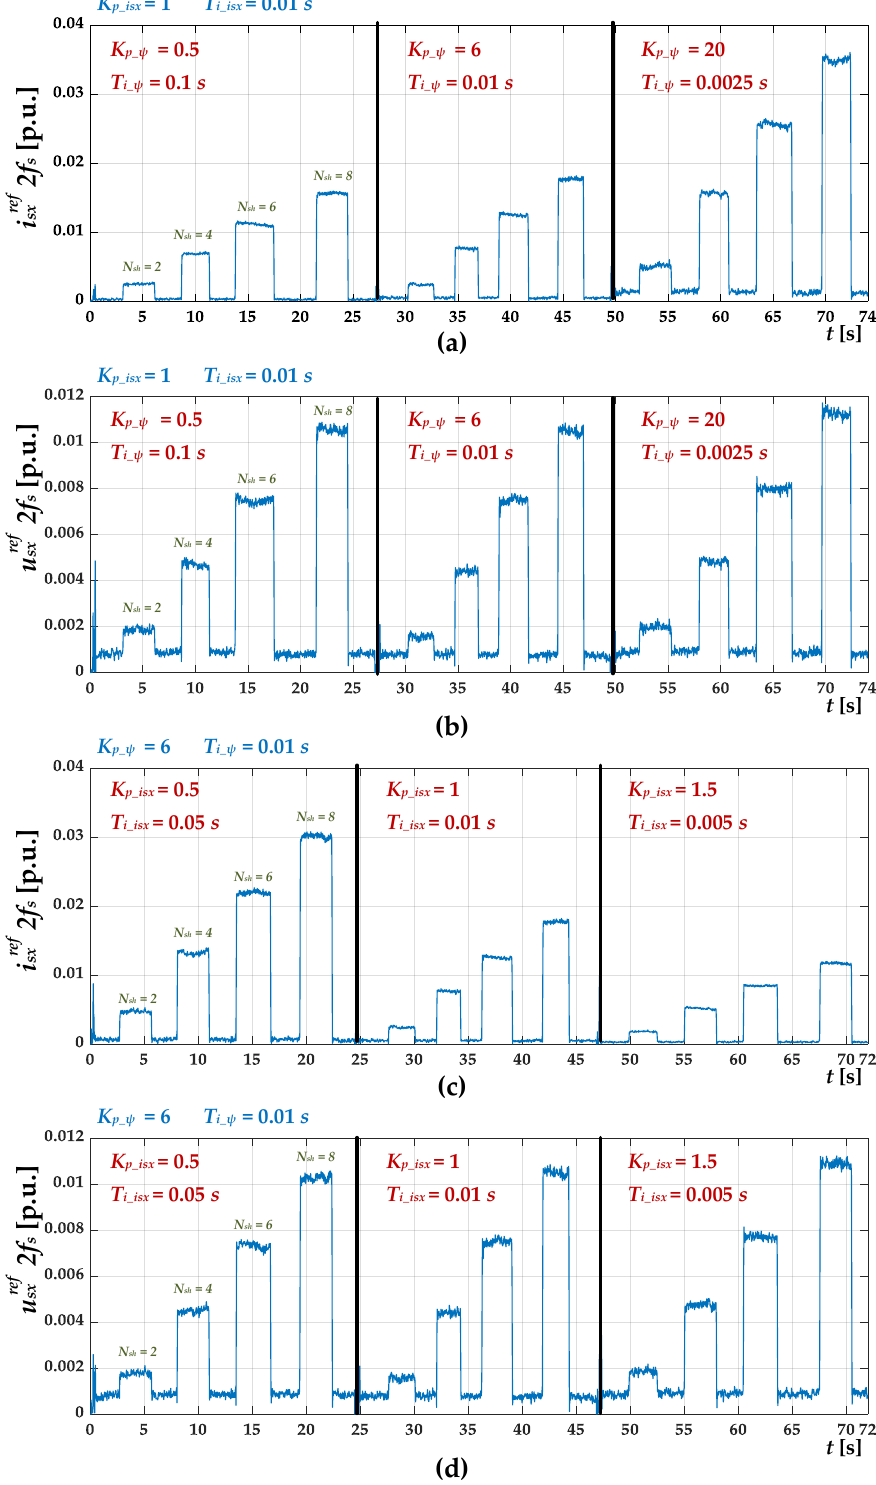
Figure 16. Influence of PI controller parameter values on the 2 f s frequency amplitudes: ( a ) field-producing current in the case of changing flux controller parameters, ( b ) field-producing voltage component in the case of changing flux controller parameters, ( c ) field-producing current in the case of i sx controller parameters, ( d ) field-producing voltage component in the case of changing i sx controller parameters.